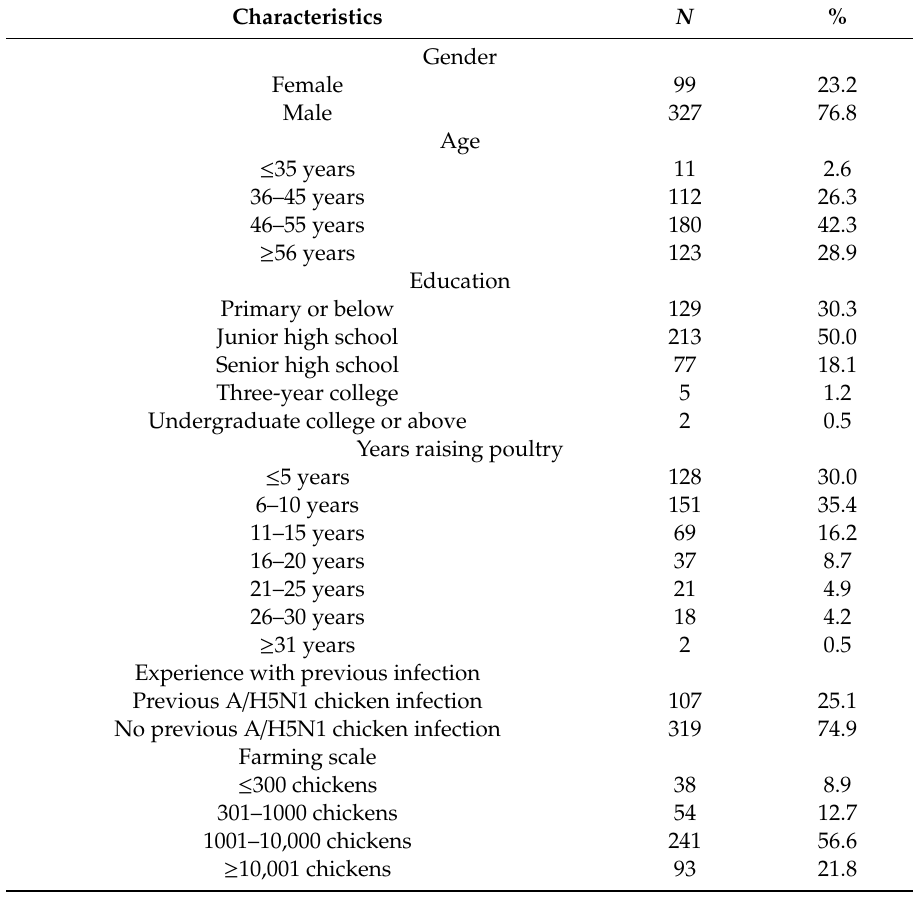
Table 1. Respondent characteristics ( N = 426).